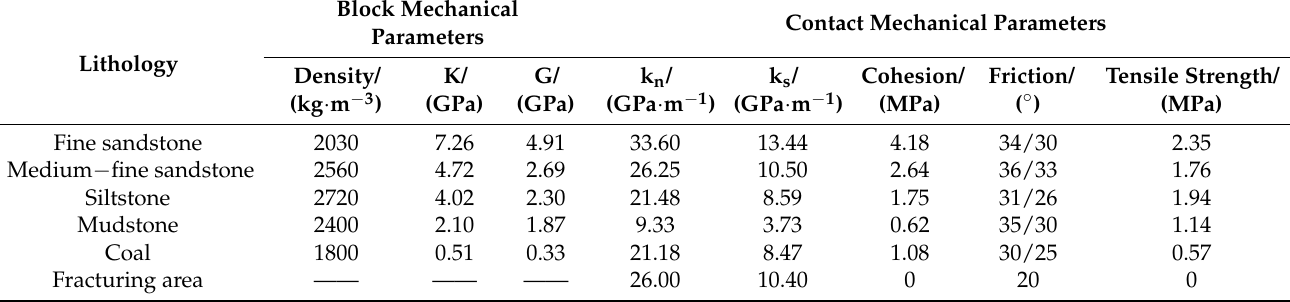
Table 3. Mechanical parameters of the rock mass used in the UDEC